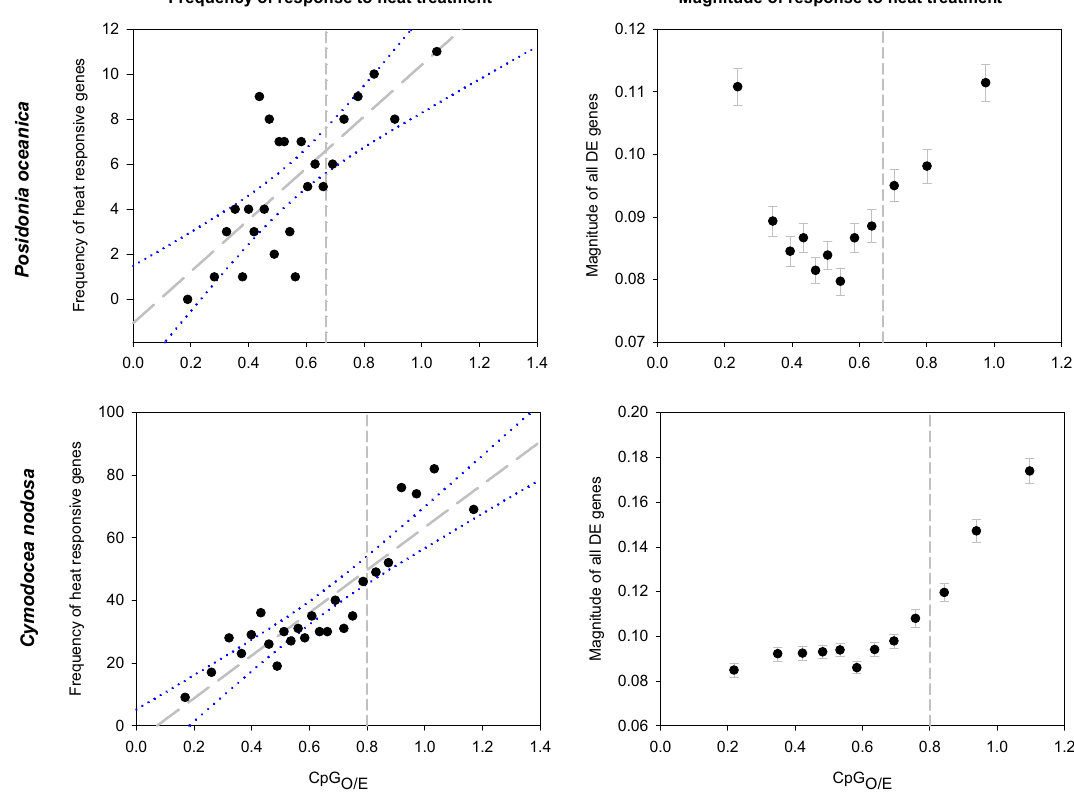
Figure 4. Relationship between CpG O/E and gene responsiveness associated to the heat treatment in P. oceanica (upper panels) and C. nodosa (lower panels). Frequency of heat flexible genes (left panels): each data point represents the number of DEGs (FDR < 0.05) responding to the heat treatment within each of the 25 CpG O/E bins. Magnitude of response to heat exposure (right panels): magnitude of differential expression for each annotated gene. Magnitude points represent the log mean differential expression value and standard error of the genes divided in 12 bins. Dashed vertical lines represent the intersection of the two fitted component curves of the bimodal distribution of CpG O/E in each species. Solid grey lines and dotted blue lines represent the Pearson correlation line and the 95% confident intervals